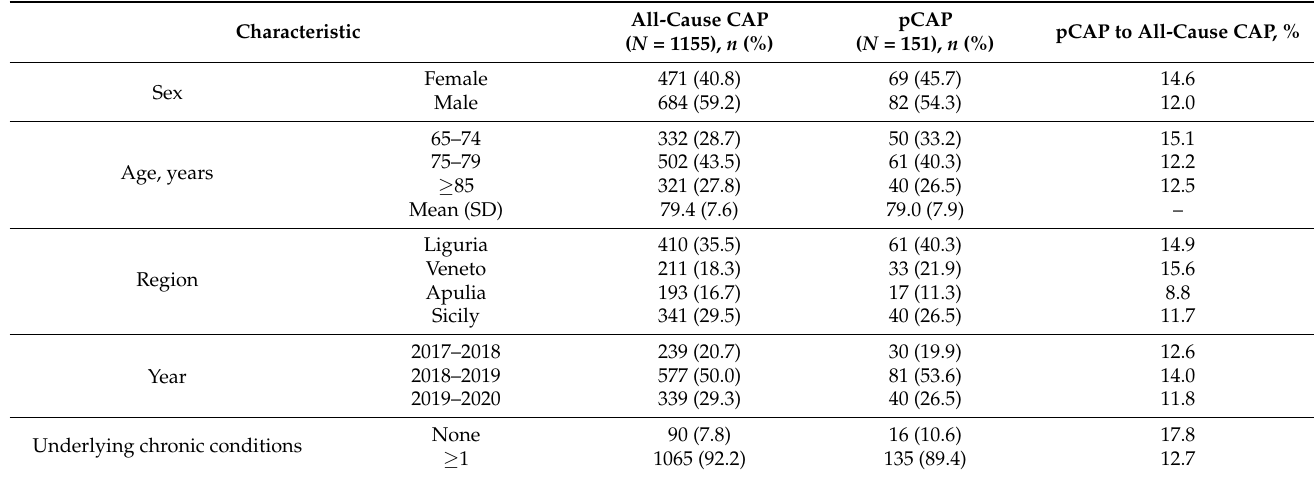
Table 1. Characteristics of the study participants.